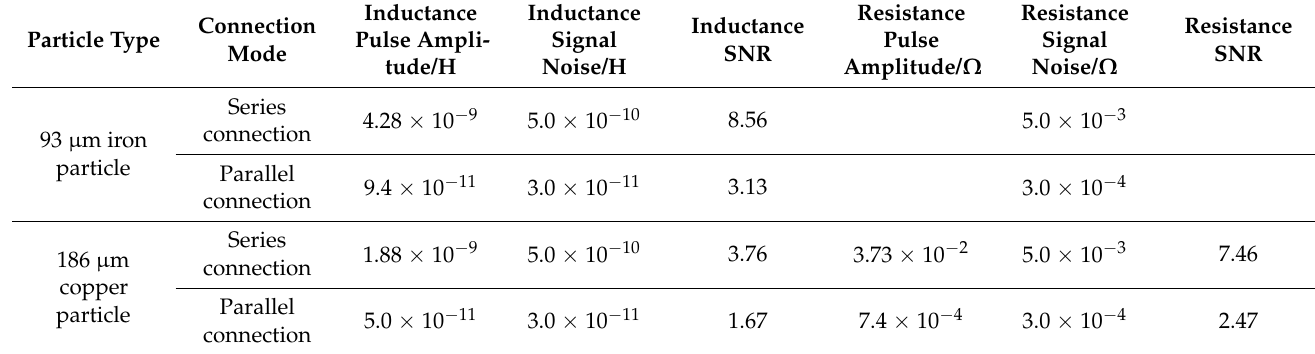
Table 1. Detection results of the sensor without silicon steel strips.